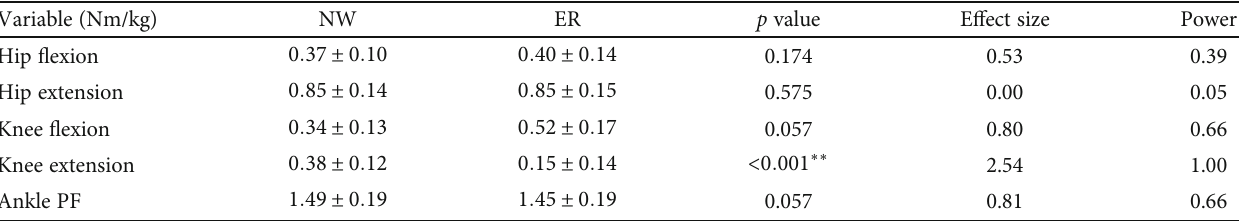
Table 3: Peak joint moments of force during